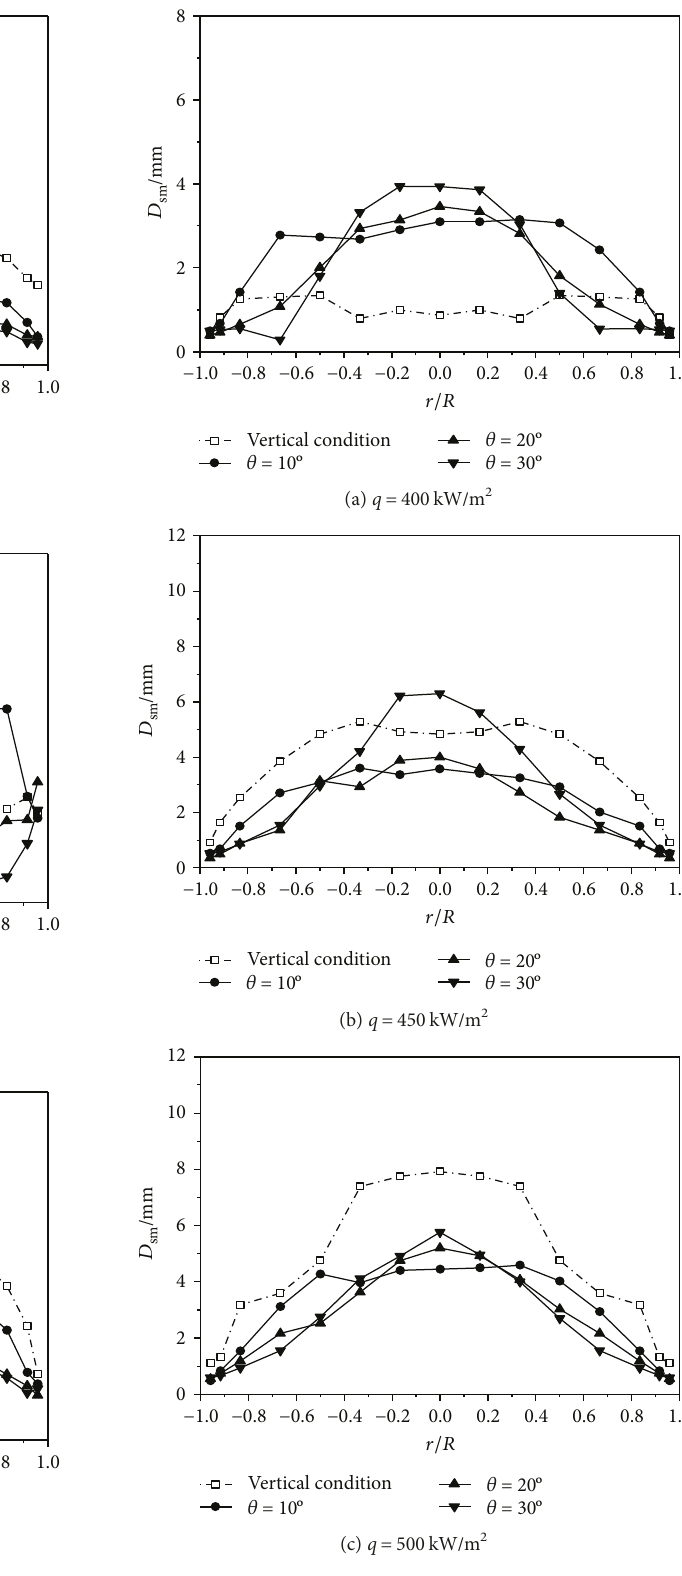
Figure 10: Inclination angle e ff ect on the bubble Sauter diameter on the direction of β = 0 ∘ in cross section ( P = 0 5 MPa, G = 500 kg/m 2